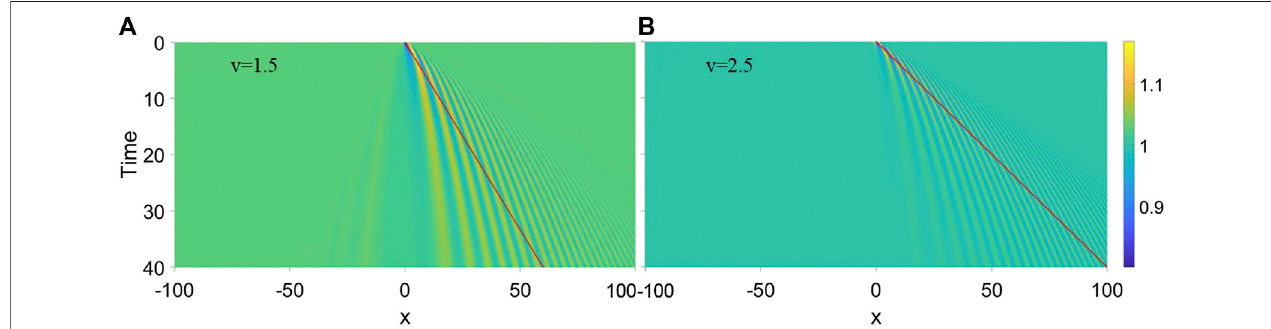
FIGURE 6 | The density pro fi les of wavefunction (10) for (A) v (cid:2) 1.5 and (B) v (cid:2) 2.5, respectively. The Gaussian wavepacket takes A (cid:2) 0.5 and σ (cid:2) 1. The red line indicates the trail of the moving